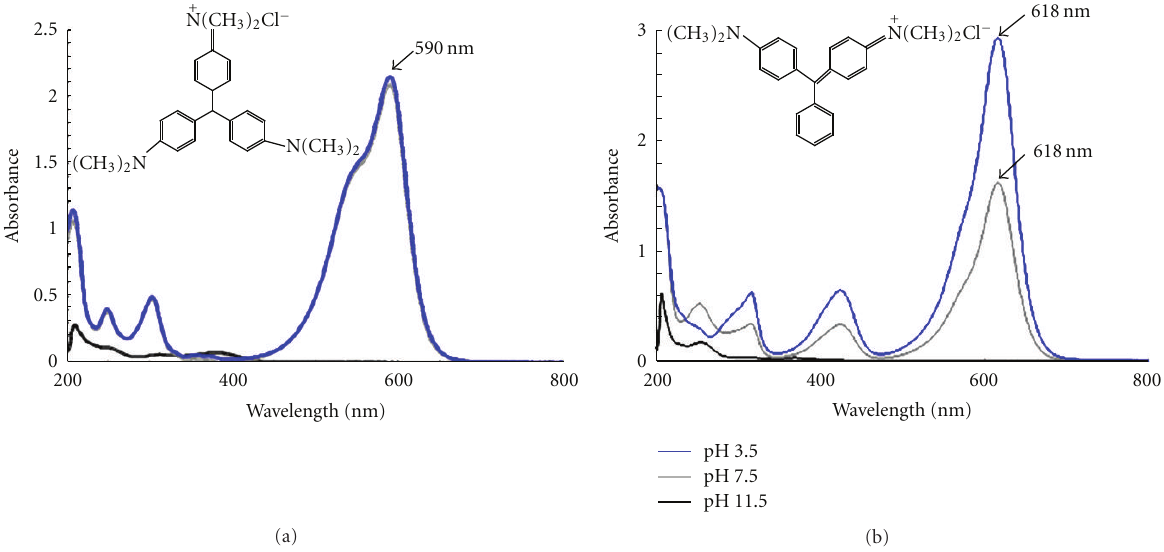
Figure 1: Chemical structure of crystal violet (a) and malachite green (b) dyes used in the present study and their spectra profiles obtained at the following pH (3.5, 7.5, and 11.5), in mineral salts medium at concentration 50 mg/L, the experience was realized at 35 ◦